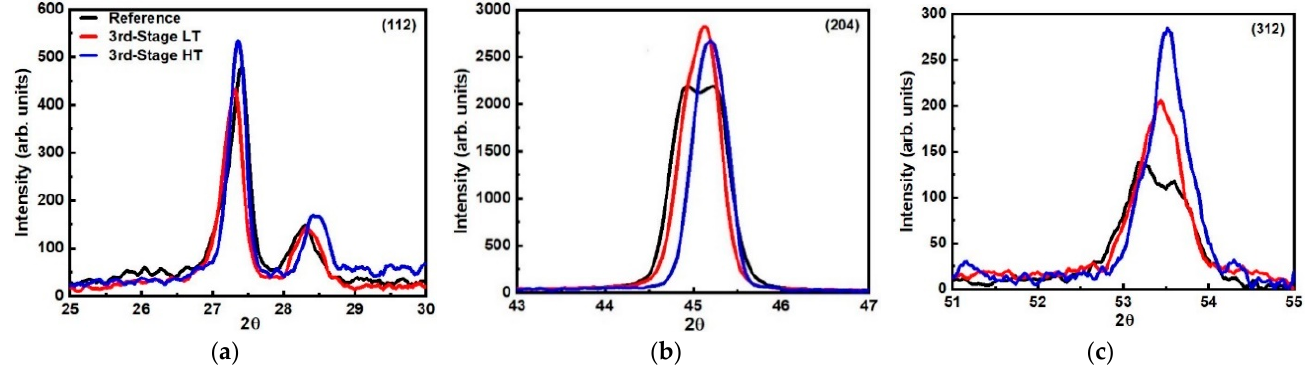
Figure 6. XRD plots for the ( a ): (112) peak, ( b ): (204) peak and ( c ) (312) peak for the reference (black), third stage LT (red) and third stage HT (blue) CIGS samples recrystallized in a CuCl 2 environment. Table 4. XRD and XRF results for reference, third stage LT and third stage HT CIGS